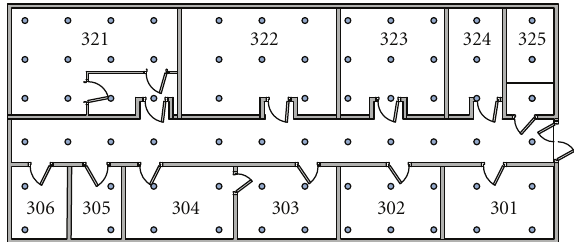
Figure 7: Environment where measurements were